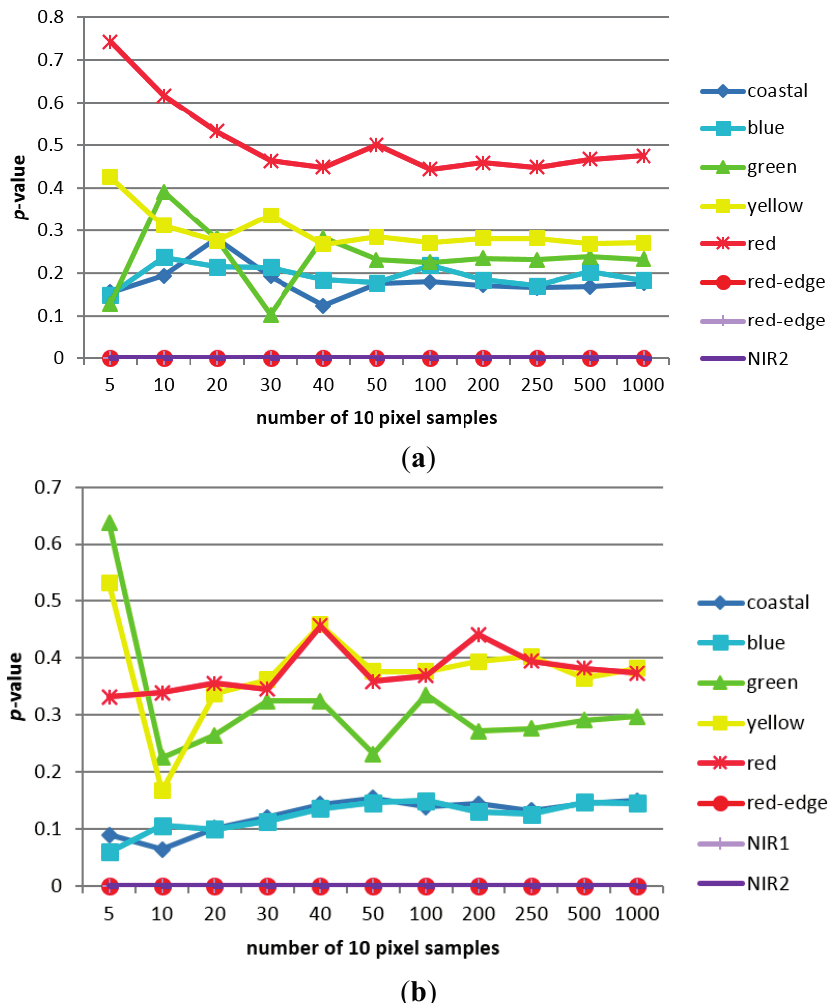
Figure 9. The per-band p -value computation between segments with different land covers (a black roof and a grass patch) when different numbers of 10 pixel samples were applied and when: ( a ) the two-sample Kolmogorov-Smirnov statistics; ( b ) the Student’s t -test statistics was